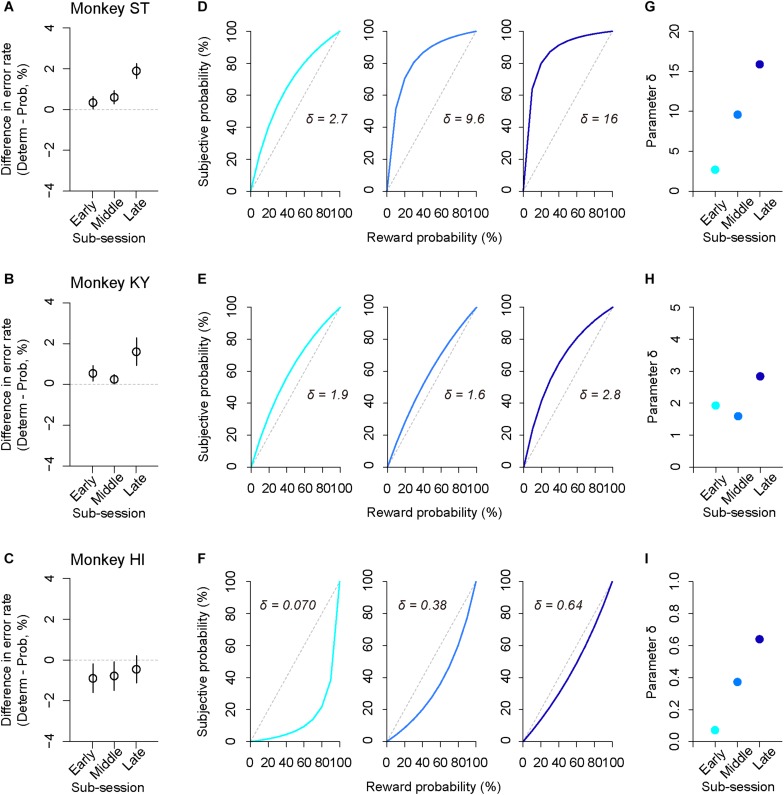
Satiation effect on risk attitude. (A–C) Difference in error rate by trial type. The error rate in the probabilistic trials was subtracted from that in the deterministic trials for each sub-session (early, middle, late). Panels are for monkeys ST (A), KY (B), and HI (C). (D–F) Shifts of probability-weighting functions (Eq. 2) according to satiation for each monkey. The best-fit function for the data of each sub-session (left: 0–0.5, center: 0.25–0.75, right: 0.5–1.0, satiation level) is displayed. (G–I) Parameter δ is plotted for each sub-session and for each monkey. Colors are the same as in D–F.